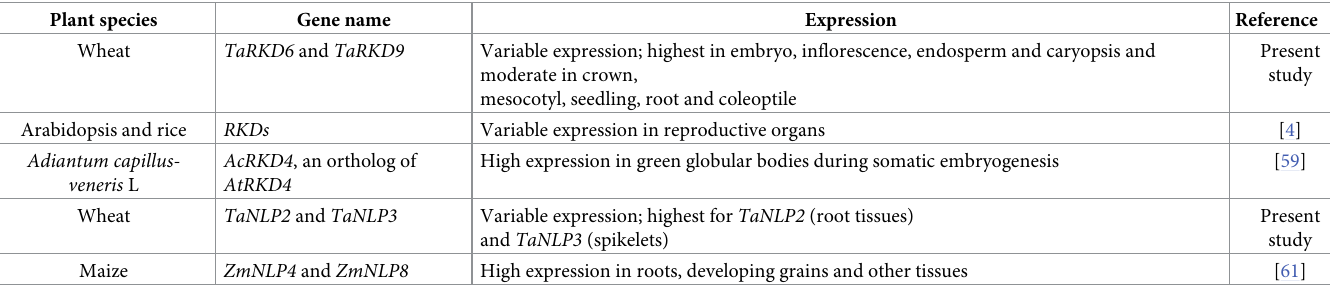
Table 4. Results of expression analysis obtained during present study and earlier